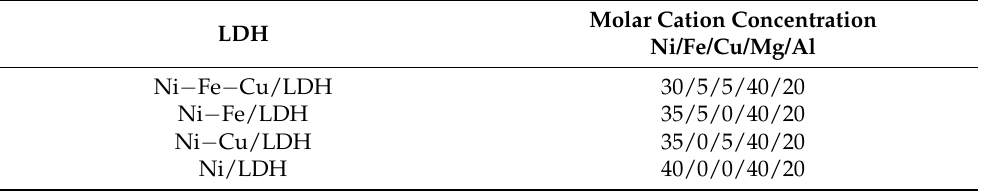
Table 1. Molar cation concentration of the synthesized layered double hydroxides